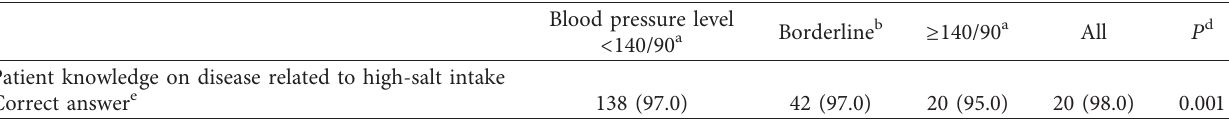
Table 4: Patient knowledge on disease related to high-salt intake based on blood pressure level.